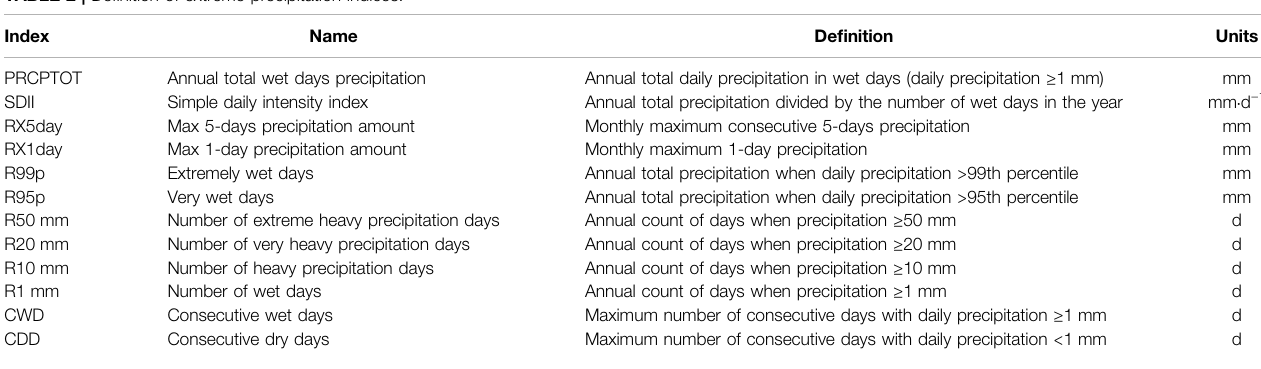
TABLE 2 | De fi nition of extreme precipitation